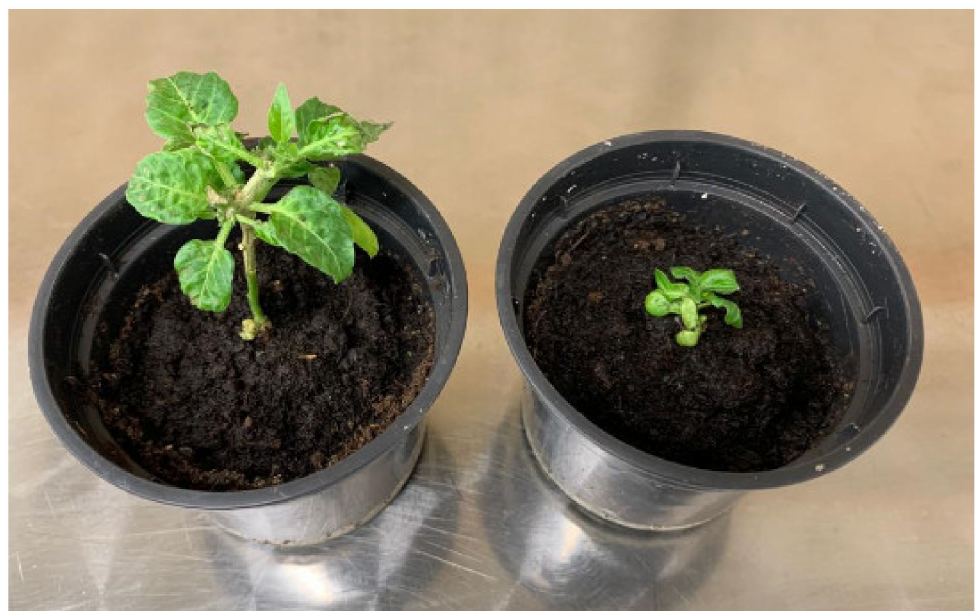
Figure 2. Anther-derived plants of ( C. annuum L. ATZ × C. annuum L. ‘Corno di toro’)F 2 : diploid on the left and haploid on the